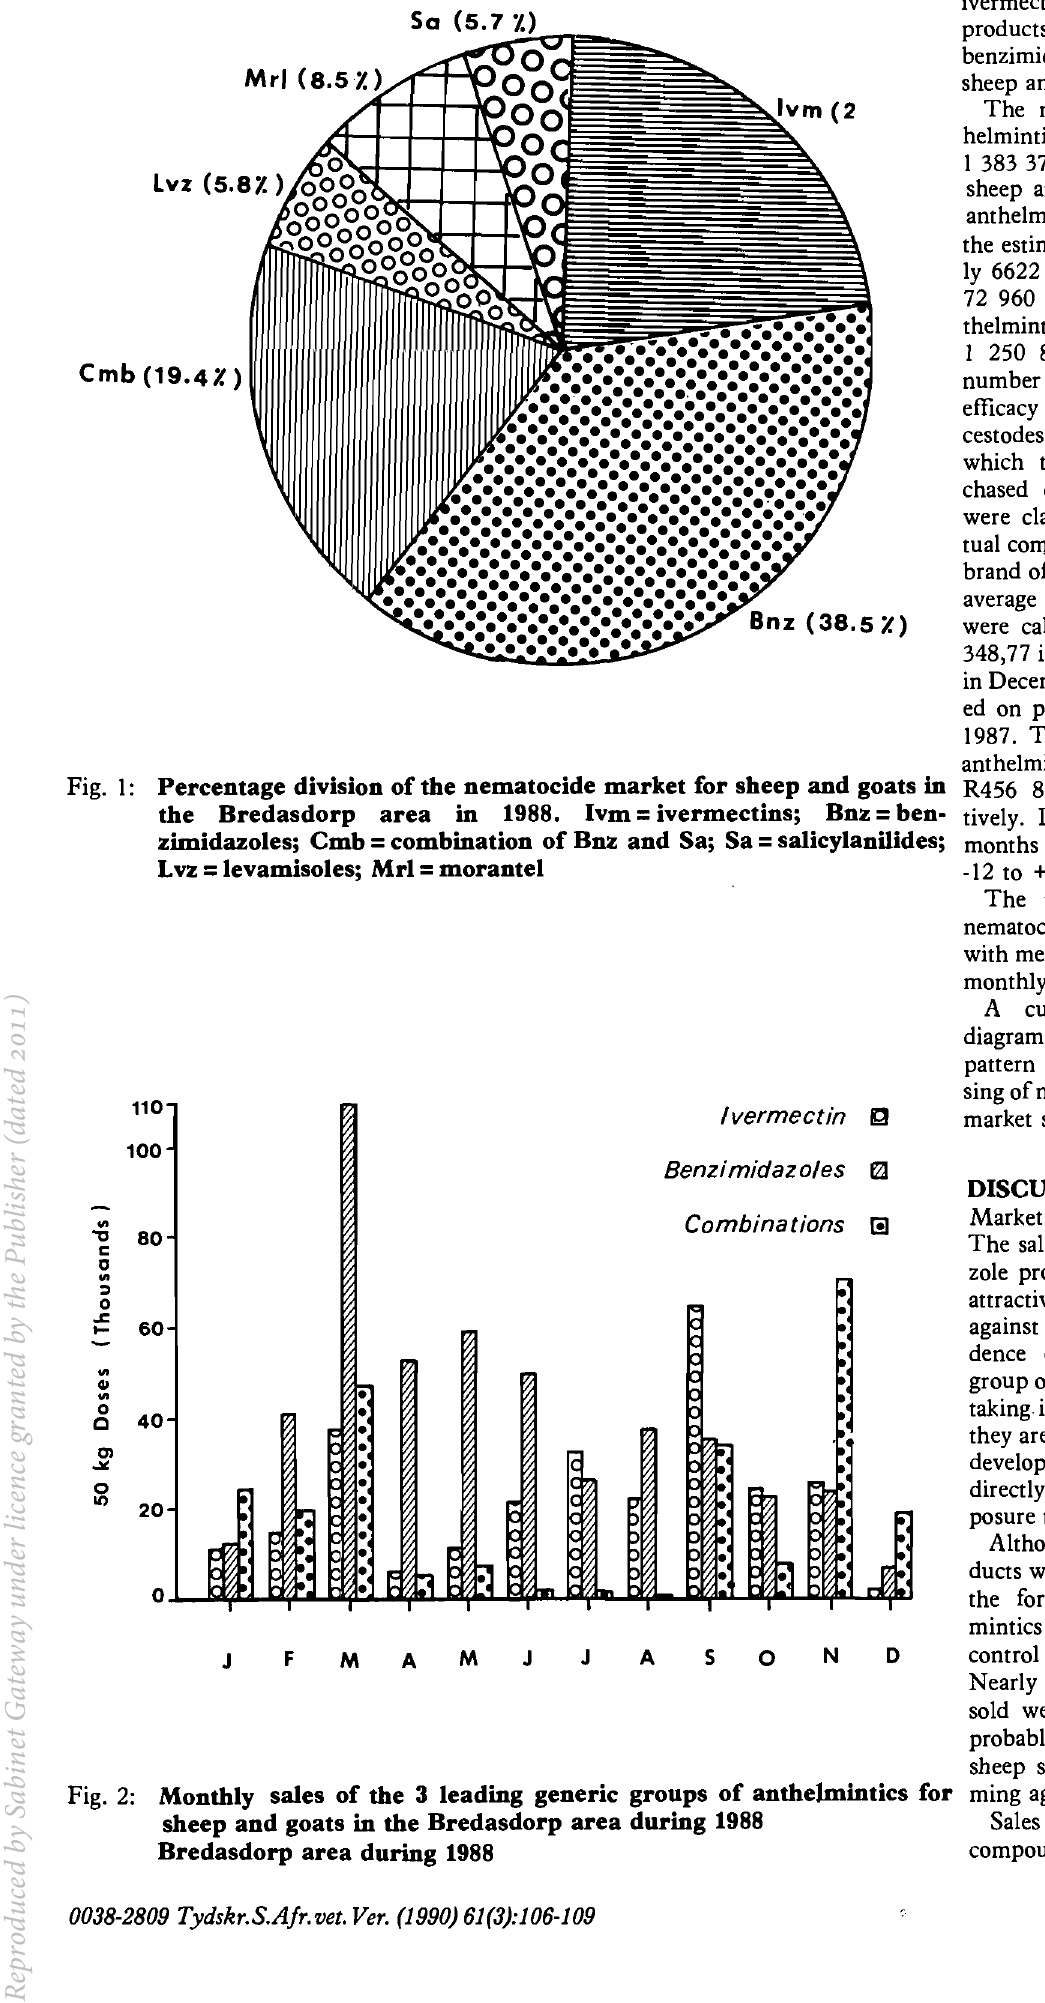
Fig. 2: Monthly sales of the 3 leading generic groups of anthelmintics for sheep and goats in the Bredasdorp area during 1988 Bredasdorp area during